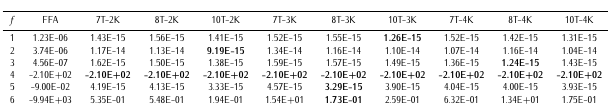
Table 2. Results: 10 fireflies and Crossover with the K best threads